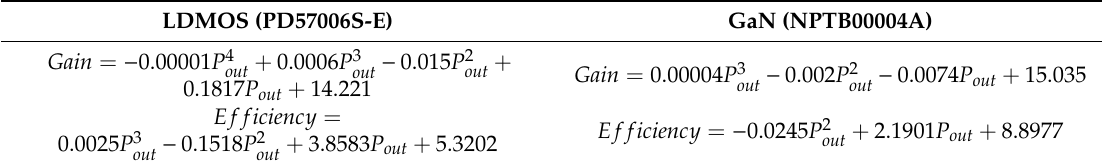
Table 2. Approximated equations for the selected LDMOS and GaN transistors. Gain is expressed in dB, E ffi ciency is expressed in percentage, and Pout (Output Power) is expressed in